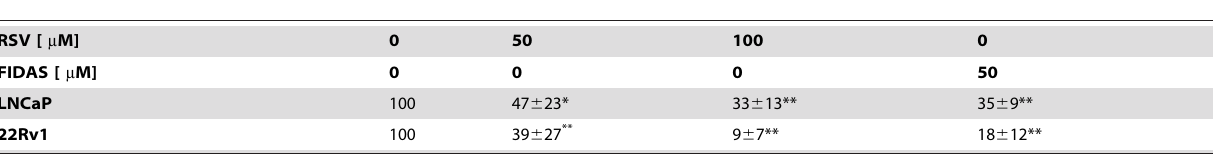
AR-positive LNCaP and 22Rv1 cells were transfected with the reporter-gene plasmids pARE(2x)-luc and pRT-TK, as described in Material and Methods. Subsequently cells were incubated with RSV or FIDAS in presence/absence of 5 nM DHT for 24 hours. AR-reporter-gene activity was determined using the Dual-Luciferase Reporter Assay System (Promega) according to the manufactures instructions. Results are expressed in % (AR DHT stimulated /AR basal activity ) which was set at 100% for RSV or FIDAS untreated cells (controls). Each value represents the mean of at least 3 independent experiments 6 standard deviation, (p-values compared to corresponding DHT- treated control *p , 0.01, **p , 0.05)